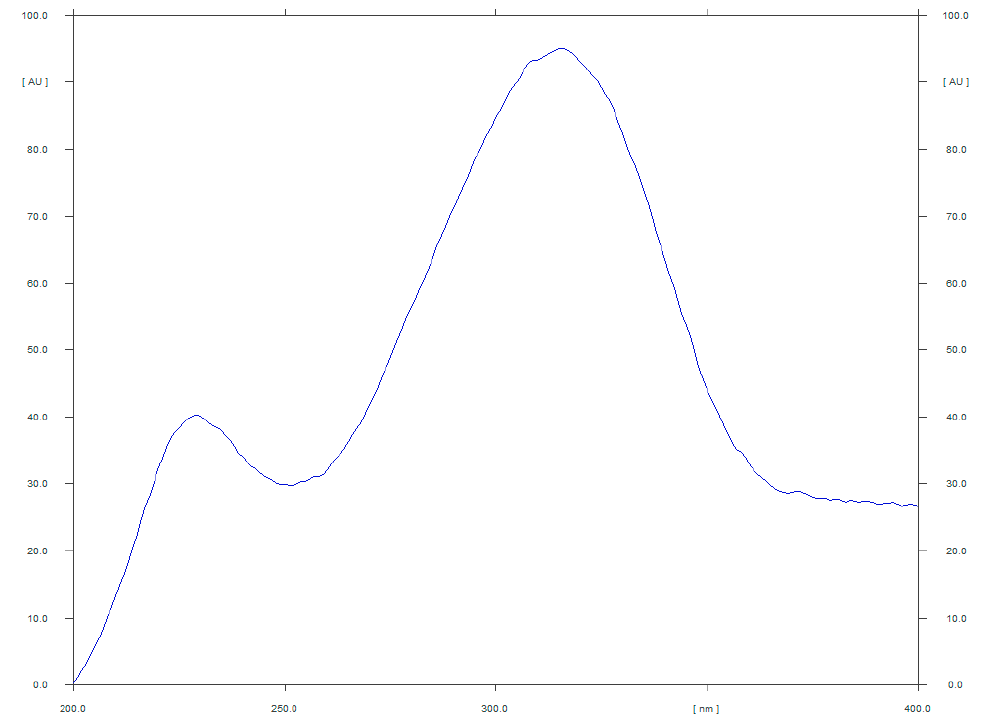
Figure 1. Absorption spectrum of ceftobiprole.